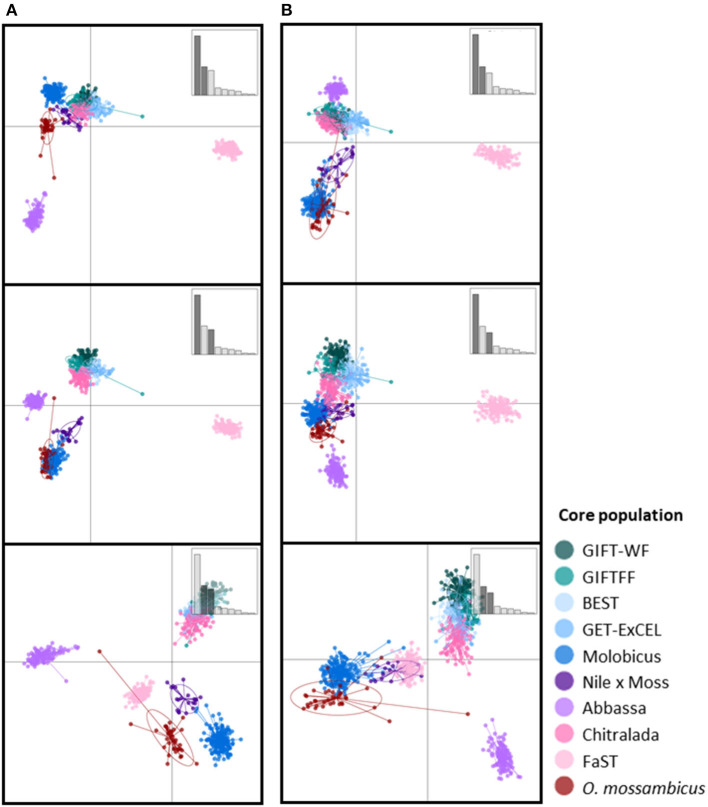
Scatterplots of the first three discriminant functions from discriminant analysis of principal components (DAPC) using (A) the full DArTseq panel and (B) the reduced subset of informative SNPs. Insets show bar plots of discriminant analysis eigenvalues, and those axes used in a given plot are darkened (so top to bottom axes 1–2, 1–3, 2–3).